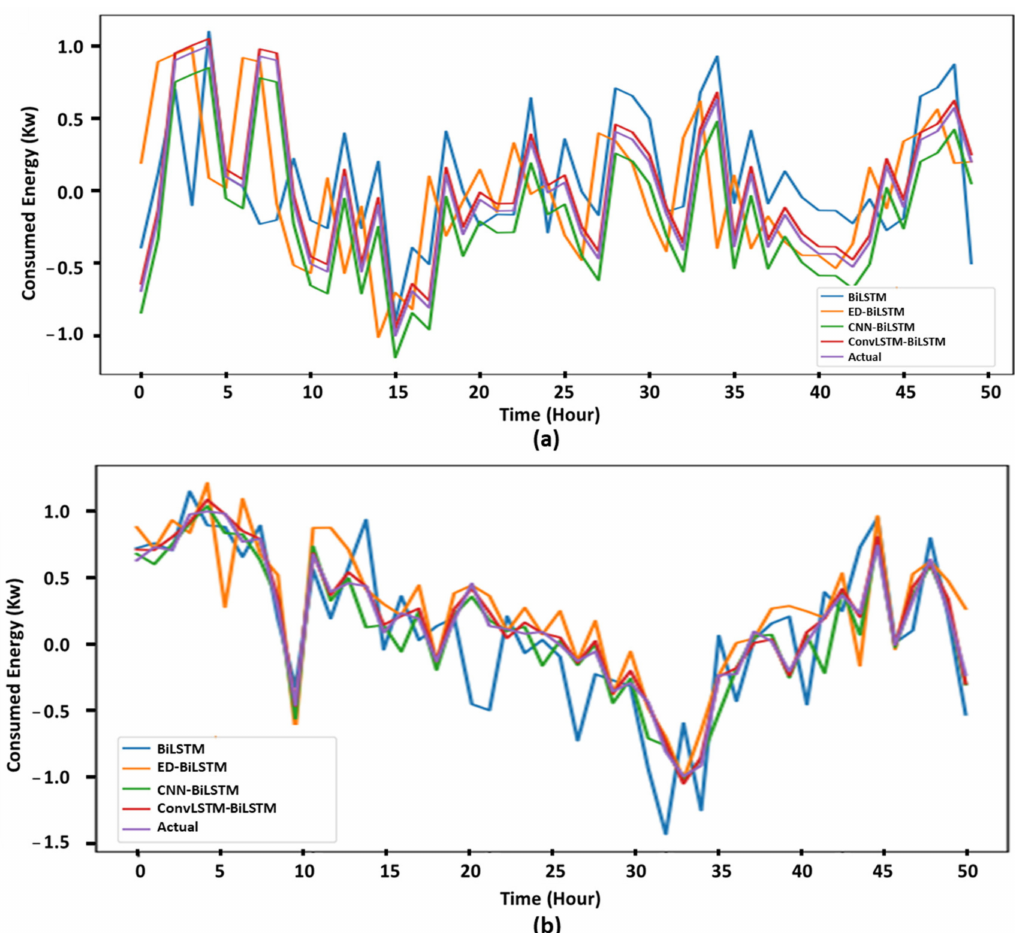
Figure 7. Prediction results of the proposed sequential models on hourly resolution data; ( a ) Household Dataset and ( b ) Commercial